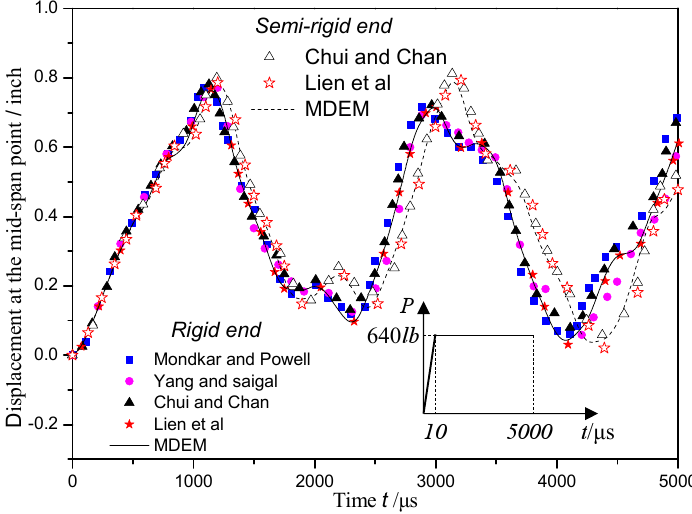
Figure 8. Displacement time history curves at the mid-span point of the beam under sudden loading.